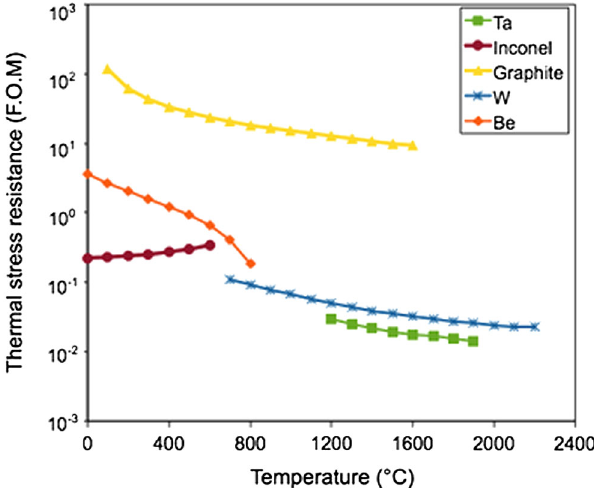
FIG. 1 (color online). Thermal stress resistance figure of merit in different target materials at different operating